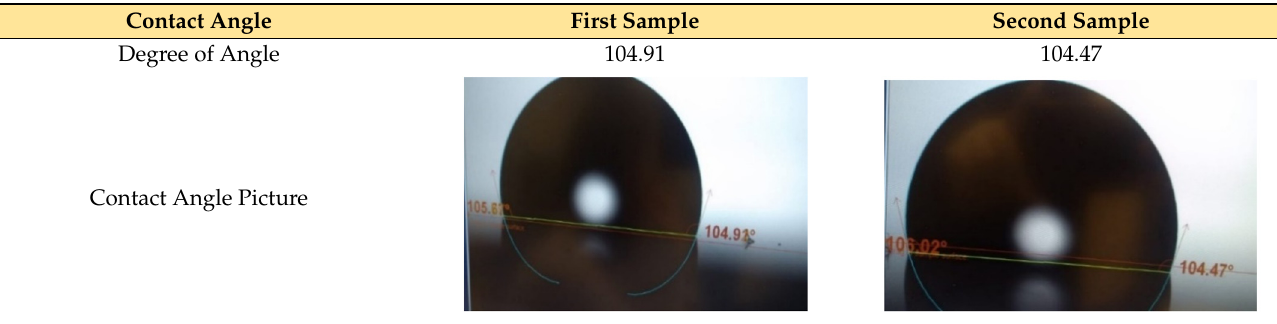
Figure 4. ( a – c ) Types of contact angle. Table 1. Contact angle results of